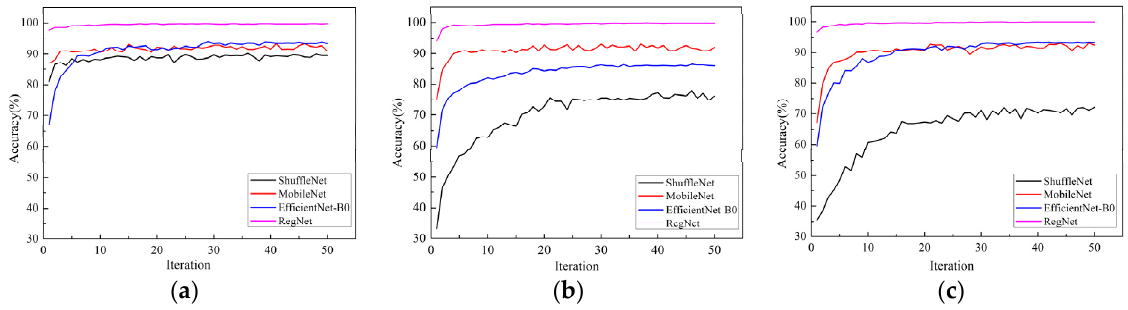
Figure 5. Comparison of different models under the same optimizer: ( a ) Adam; ( b ) RAdam; ( c ) Ranger.